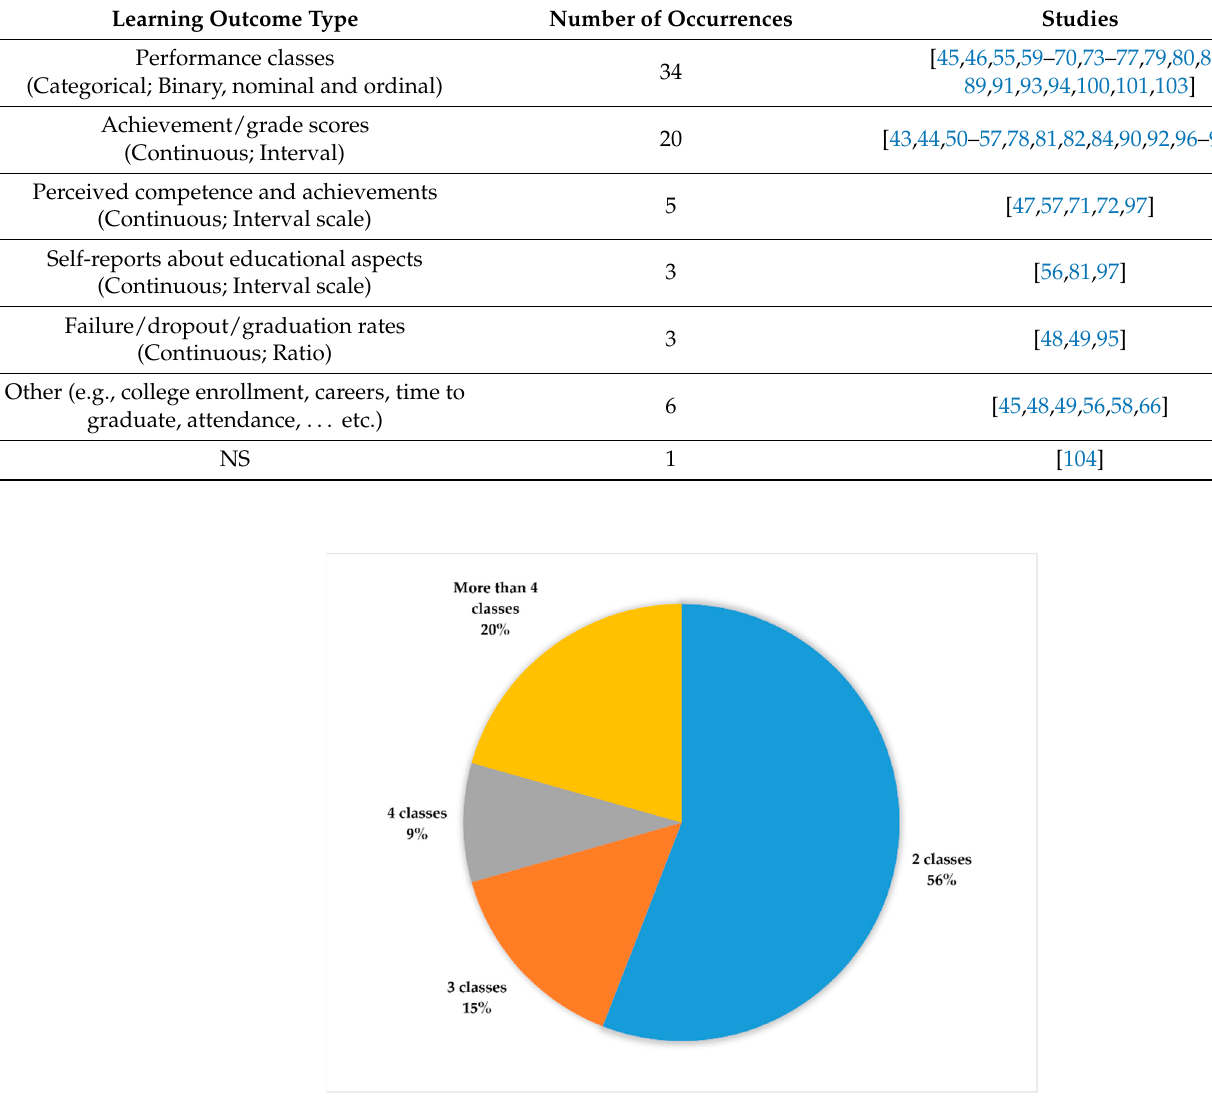
Figure 11. Distribution of student performance class labels predicted in the models predicting learning outcome as standings (i.e., ranks).